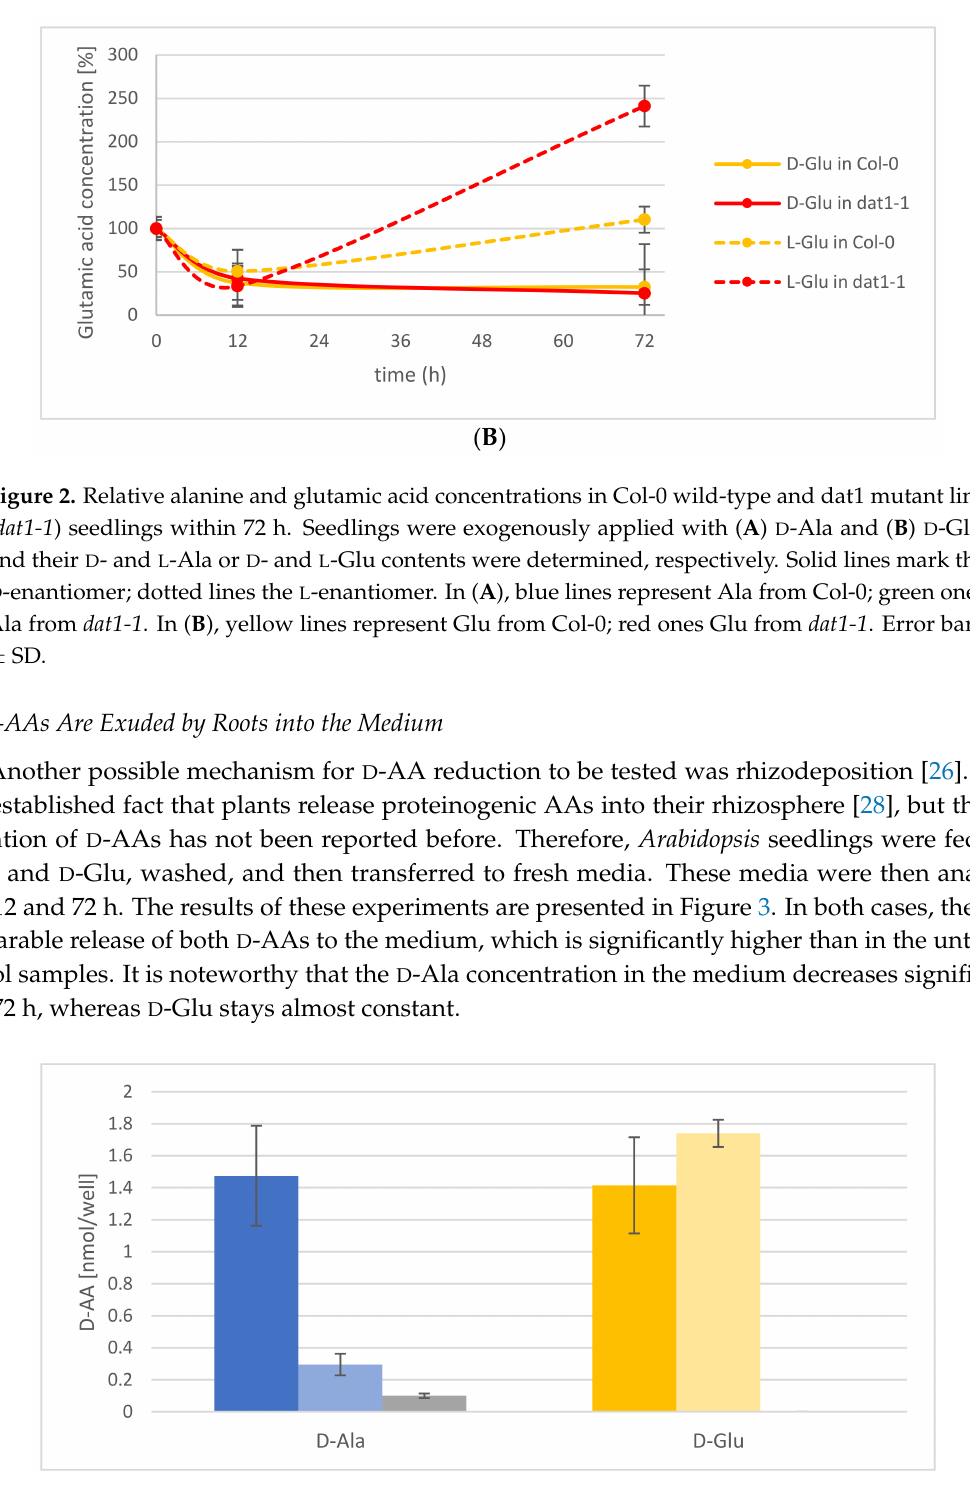
Figure 3. Contents of D -Ala and D -Glu in media released by Arabidopsis seedlings treated with both D -AAs. Dark blue and light blue bars represent D -Ala content per well 12 and 72 h after transfer from the D -Ala application medium to fresh medium, respectively. The grey bar represents the 72 h values for media from control plants without D -Ala treatment. Dark-yellow and light-yellow bars represent D -Glu concentration per well 12 and 72 h after transfer from the D -Glu application medium to fresh medium, respectively. D -Glu was not detected in the medium of untreated plants. Error bars: ±